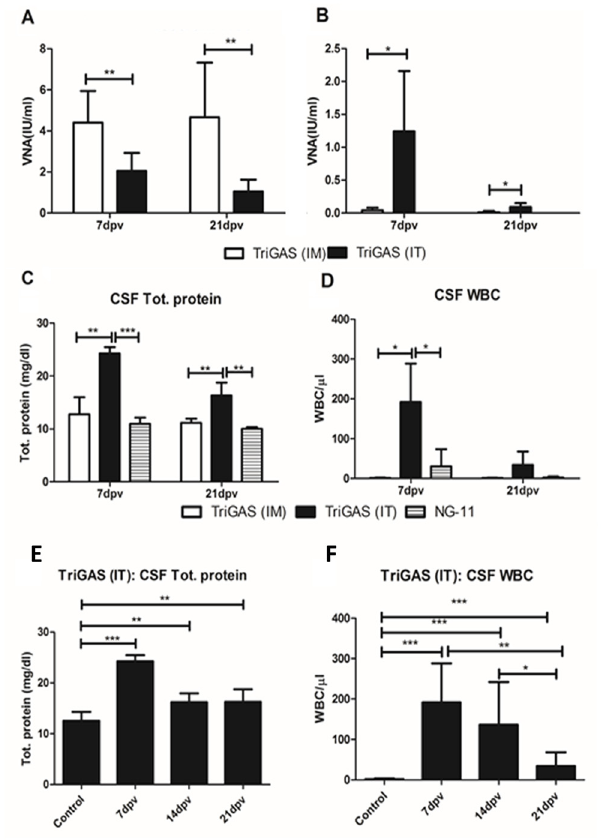
Fig 4. Intrathecal (IT) immunization with a single dose of laboratory-attenuated TriGAS induces high level of VNA in the serum and the CSF, and induces transient opening of blood-brain barrier in dogs. VNA detected in serum (A) and in CSF (B). Analysis of total protein (C) leukocytes (D) in the CSF. Kinetics of total protein (E) and leukocytes (F) influx into the CSF.